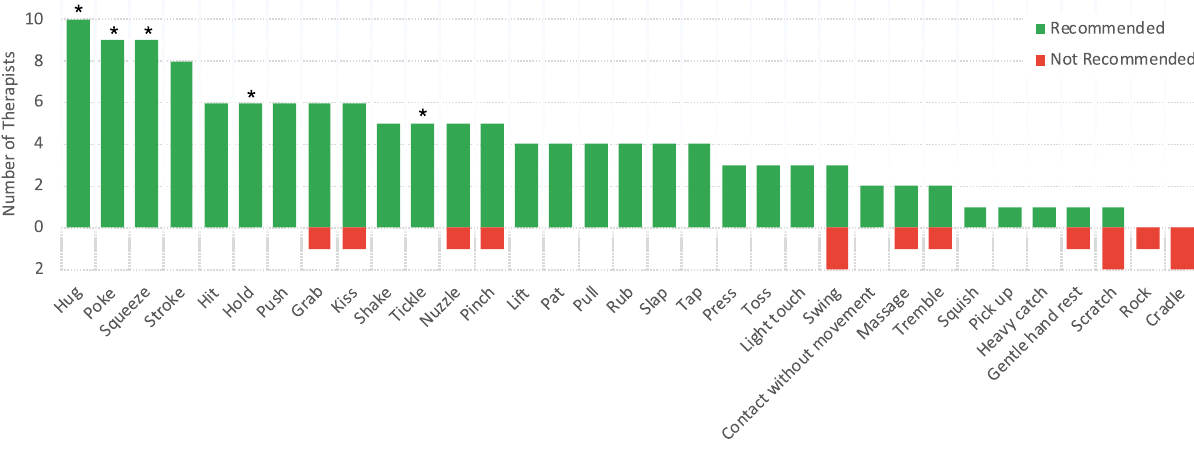
Figure 6: A visualization of the touch gestures that specialists recommended ( or did not recommend ) a touch - perceiving robot companion should be able to detect from children with autism. An asterisk above a gesture indicates that it was selected as a “ top fi ve ” gesture by more than three